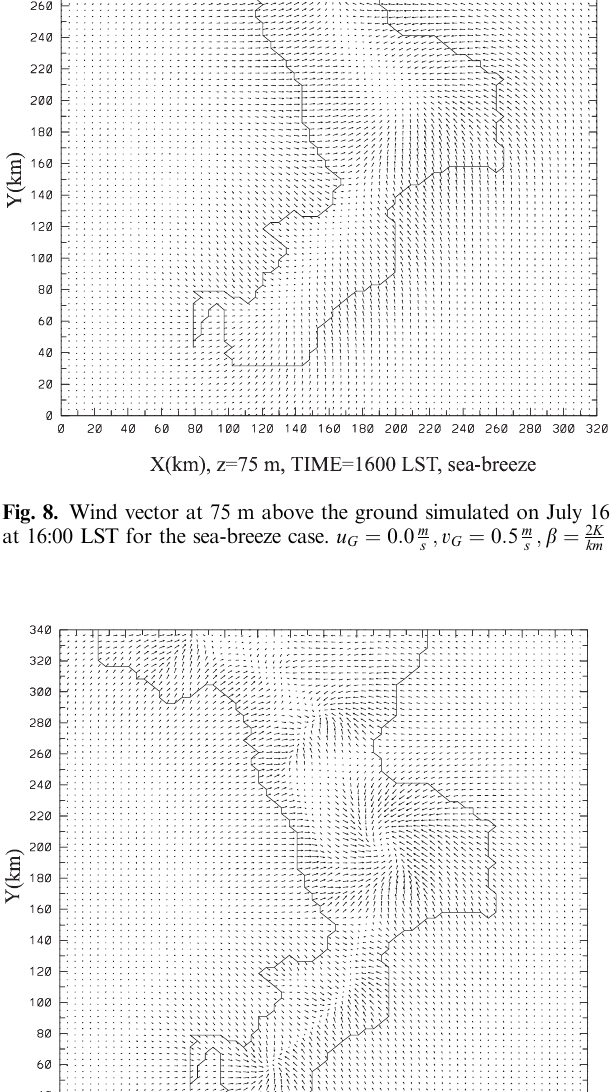
Fig. 7a–f. Mesoscale available potential energy and mean wind when both contrasts, i.e. sea-land and mountain-valley, are present (Fig. 5a–d). a , c and e refer to the MAPE and correspond to CBL heights of h